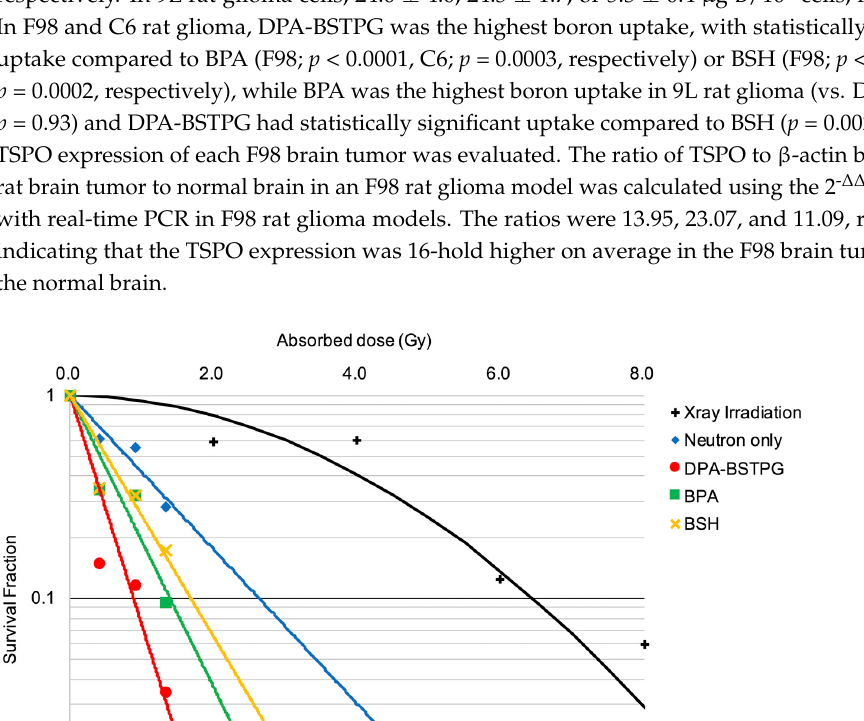
Figure 1. ( A ) This figure shows the cellular uptakes of boron using three boron-10 compounds. DPA- BSTPG, BPA, or BSH for F98 glioma cell lines were 60.3 ± 3.8, 11.9 ± 0.5, or 3.0 ± 0.2 μ g boron ( B )/10 9 cells, respectively. In C6 rat glioma cells, 26.0 ± 2.4, 6.5 ± 0.2, or 3.2 ± 0.1 μ g B/10 9 cells, respectively.